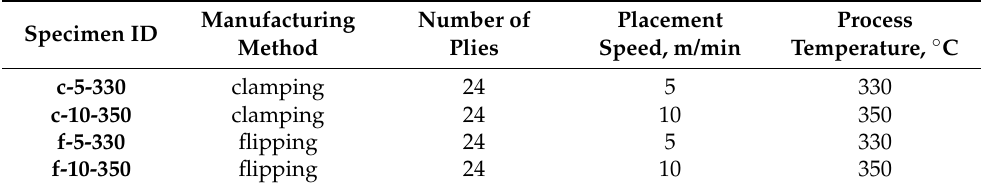
Figure 1. Schematic drawing of ( a ) the clamping and ( b ) the flipping method. The insert film is marked in red, the frame is marked in green. The fiber direction is into the page. Table 1. Manufacturing parameters of unidirectional carbon fiber reinforced polyphenylene sulfide (UD CF/PPS) panels produced by